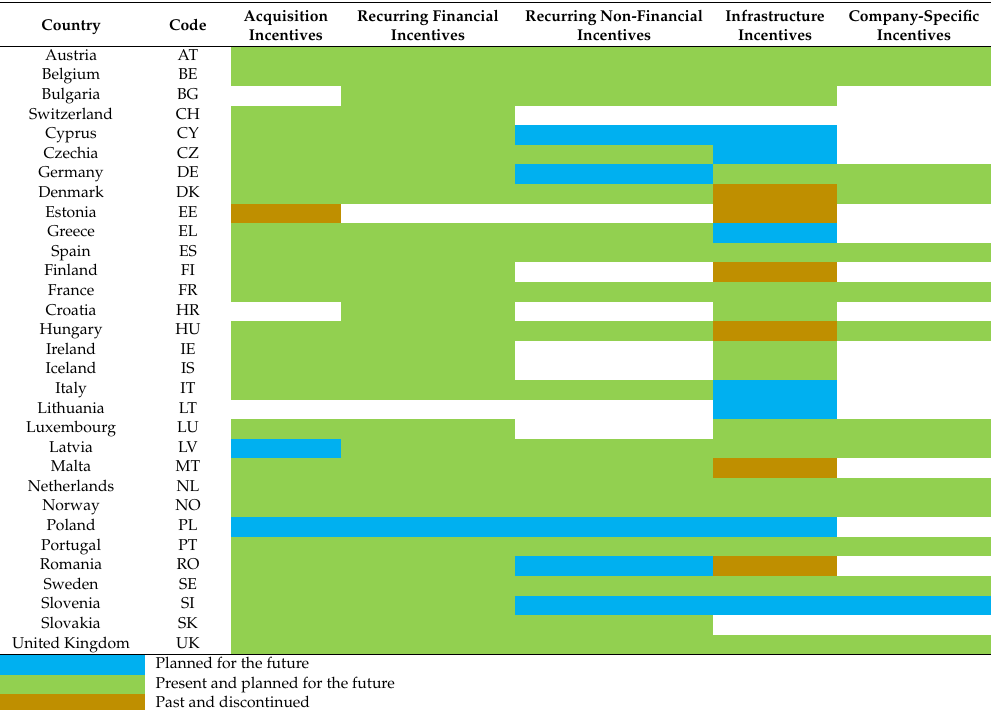
Table 2. Support measures for electro-mobility in Europe